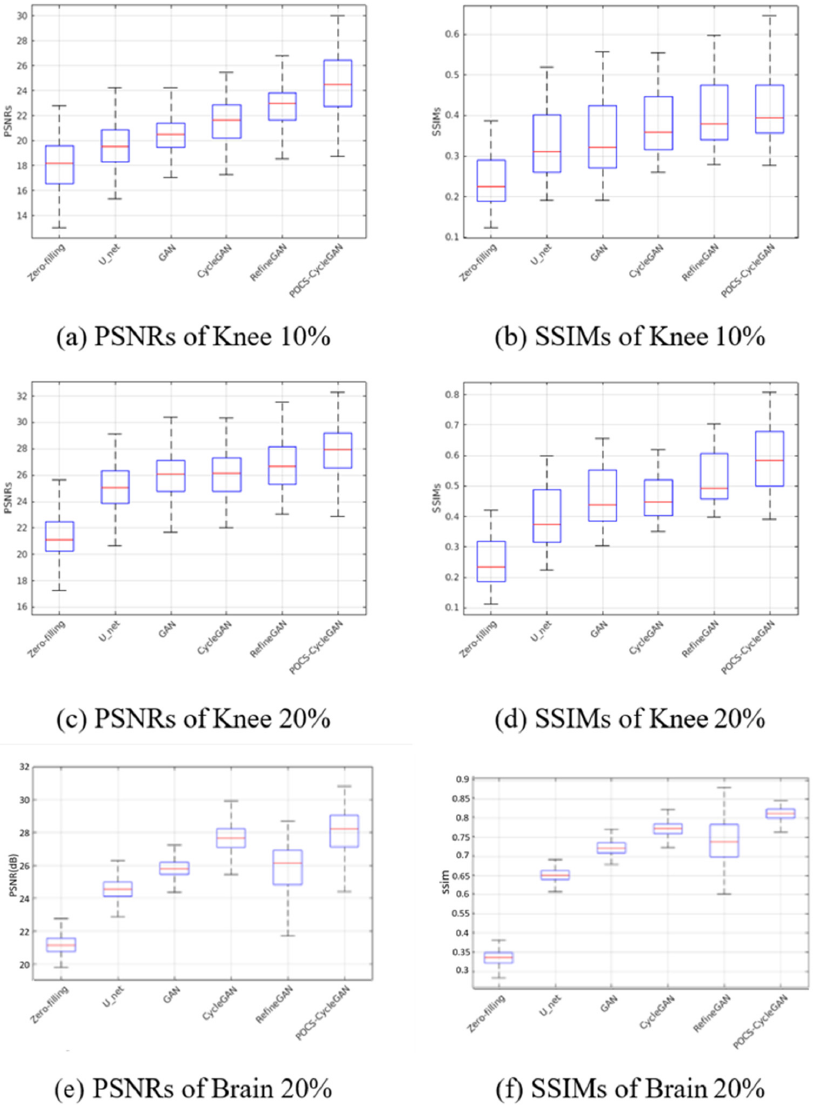
Figure 5. SSIM and PSNR evaluations of the brain and knee test set. Table 1. PSNR (mean standard deviation) of different methods with different sampling rates for the NYU dataset.